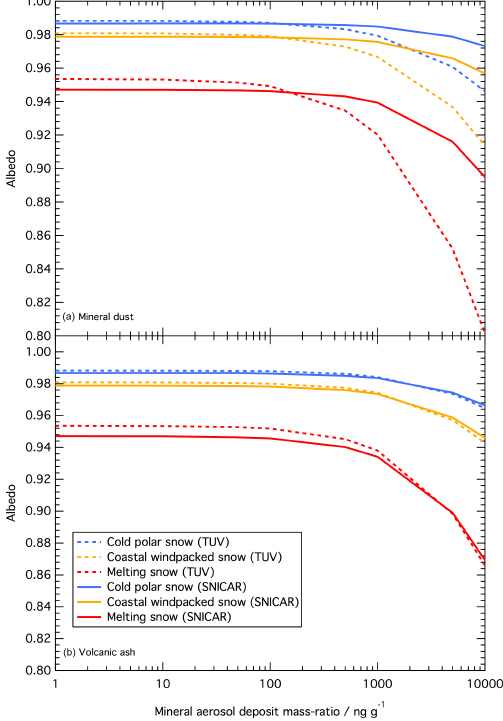
Figure 8. Comparison between the albedo of three semi-infinite snow types with an increasing mass ratio of mineral aerosol de- posits computed with TUV-snow and SNICAR-online models. The dotted lines show albedo as a function of an increasing mass ratio of Asian dust (a) and a light coloured sample of Mt St Helens volcanic ash (b) . The solid lines show the output from the SNICAR-Online model (Flanner et al., 2007) using input parameters matching